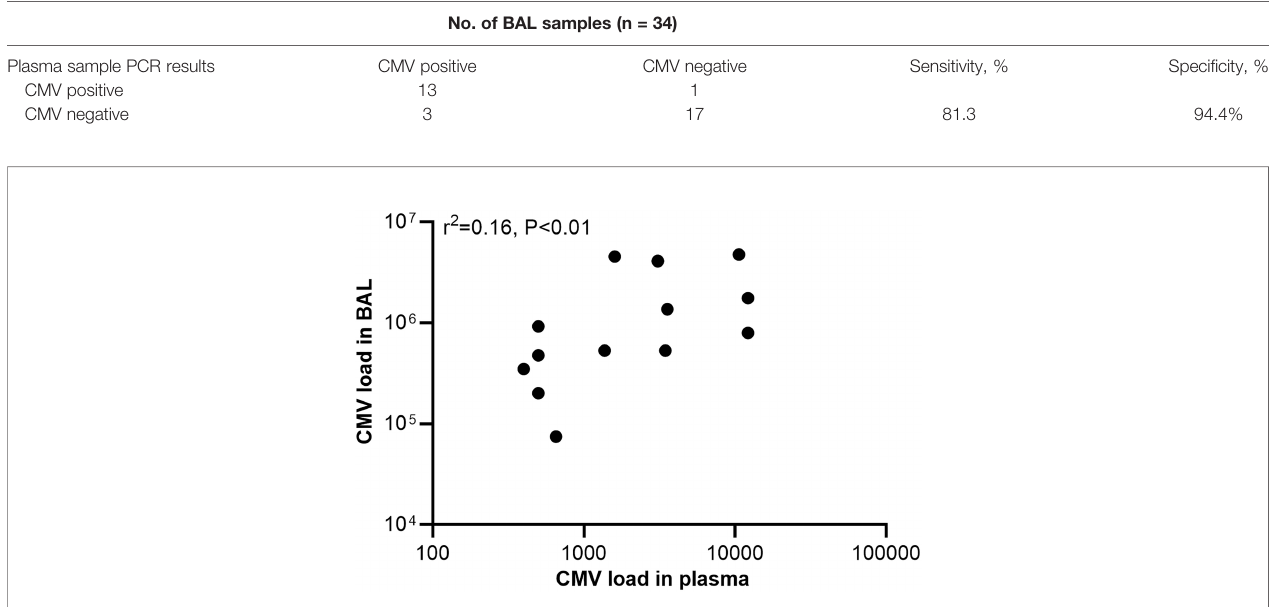
FIGURE 2 | Regression plot comparing concordant detection of cytomegalovirus (CMV) DNA in plasma and bronchoalveolar lavage (BAL) samples. CMV load was recorded as CMV DNA copies per milliliter.